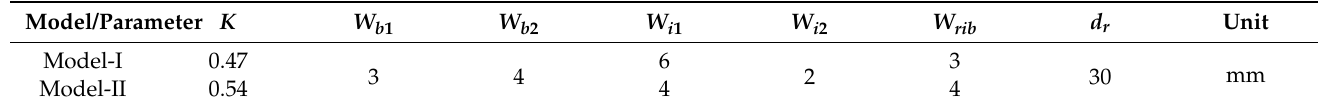
Table 2. Rotor Design Parameters.